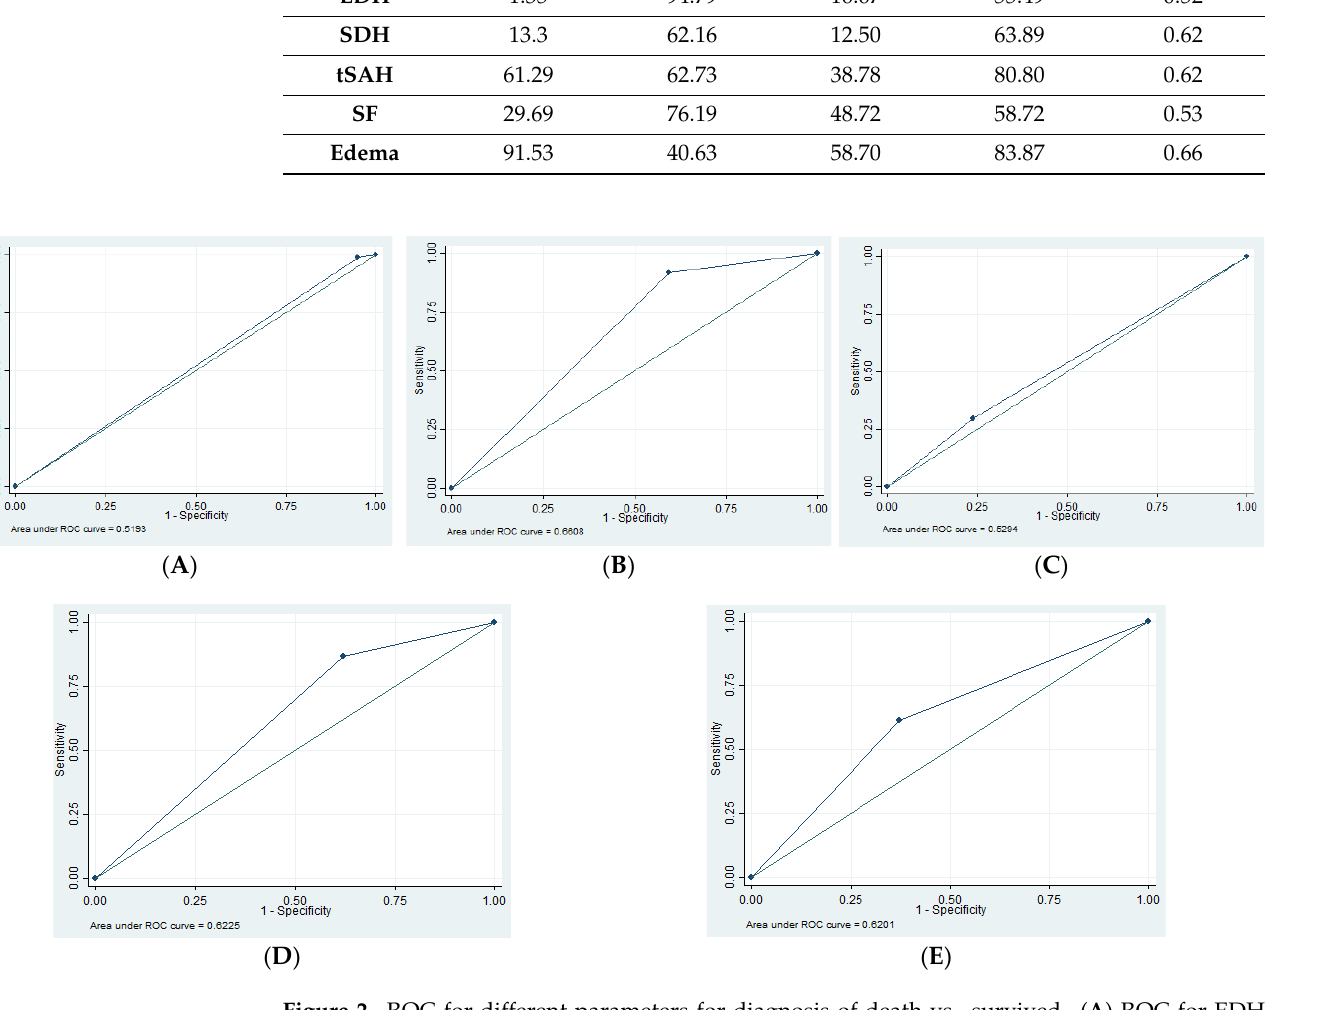
Figure 3. Forest plots for different imaging parameters for diagnostic accuracy of death vs. survival. ( A ) Forest plots showing the confidence interval for sensitivity and specificity of EDH. ( B ) Forest plots showing the confidence interval for sensitivity and specificity of edema. ( C ) Forest plots show ‐ ing the confidence interval for sensitivity and specificity of skull fractures. ( D ) Forest plots showing the confidence interval for sensitivity and specificity of SDH. € Forest plots showing the confidence interval for sensitivity and specificity of tSAH.